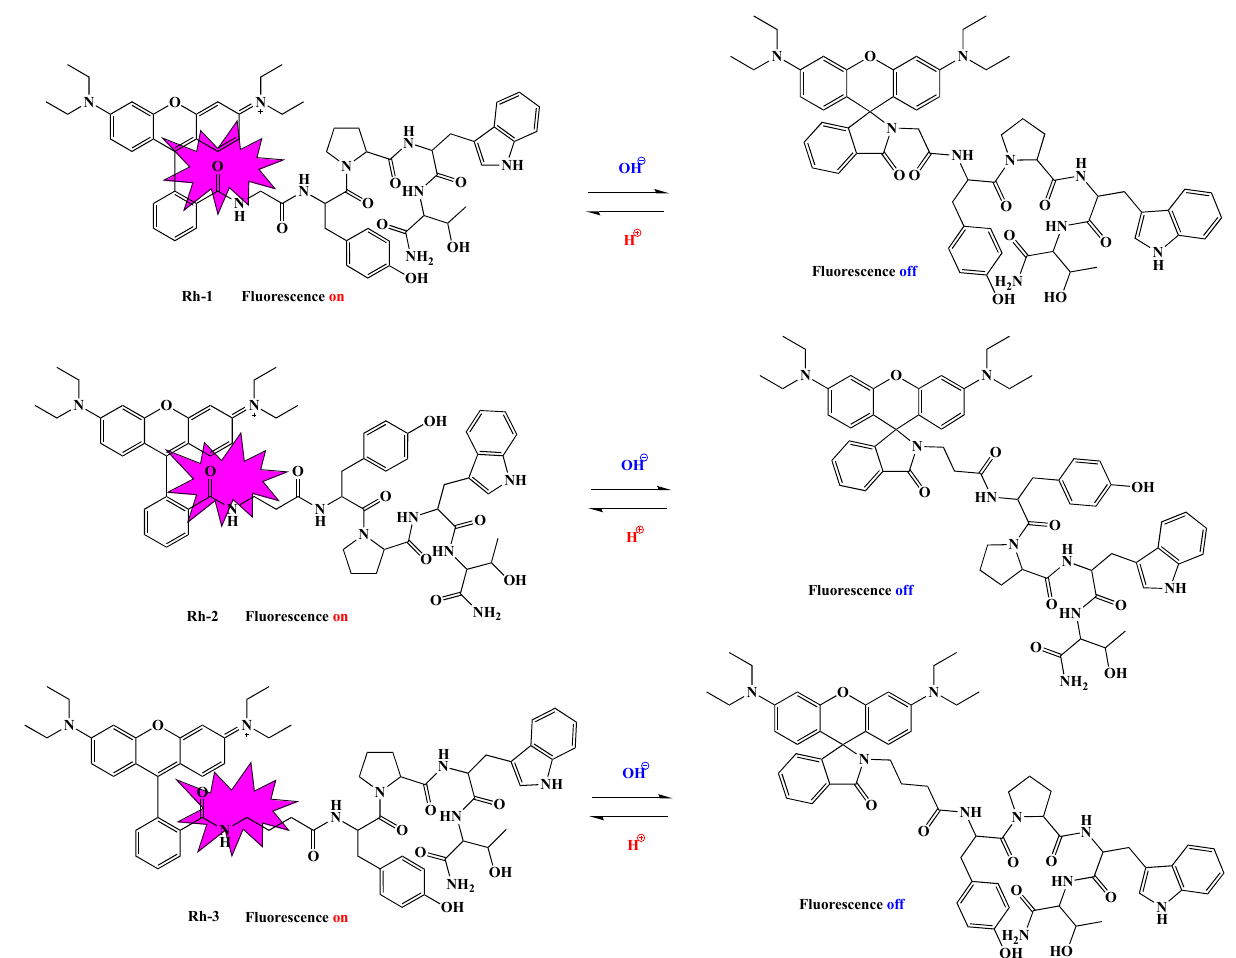
Figure 3. pH-dependent equilibrium between the spirolactam form and the ring-opened form of rhodamine B-conjugated hemorphin-4 analogues.